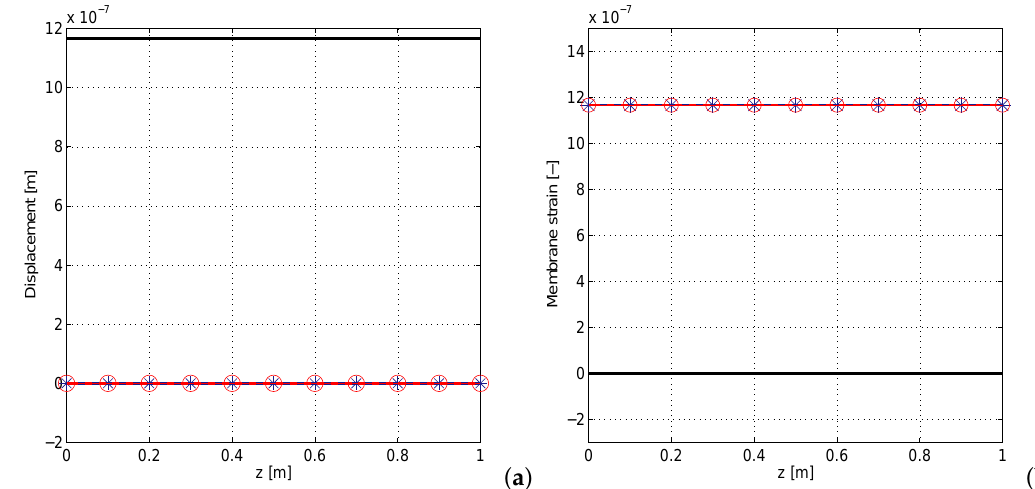
Figure 10. Spherical shell under uniform pressure. ( a ) Displacement components: u - blue solid line with stars, v - red dotted line with circles, w - black solid line. ( b ) Strain components: ε 11 - blue solid line with stars, ε 22 - red dotted line with circles, ε 12 - black solid line.